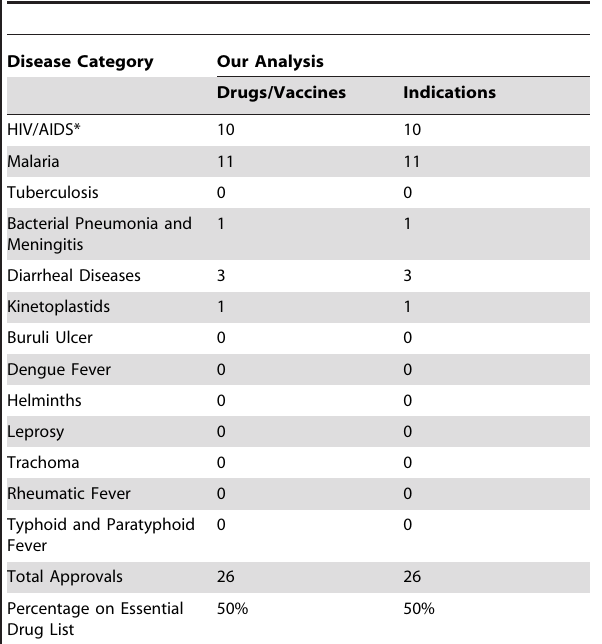
Table 2. Numbers of 2000–2009 Approvals for G-Finder Defined Neglected Diseases.